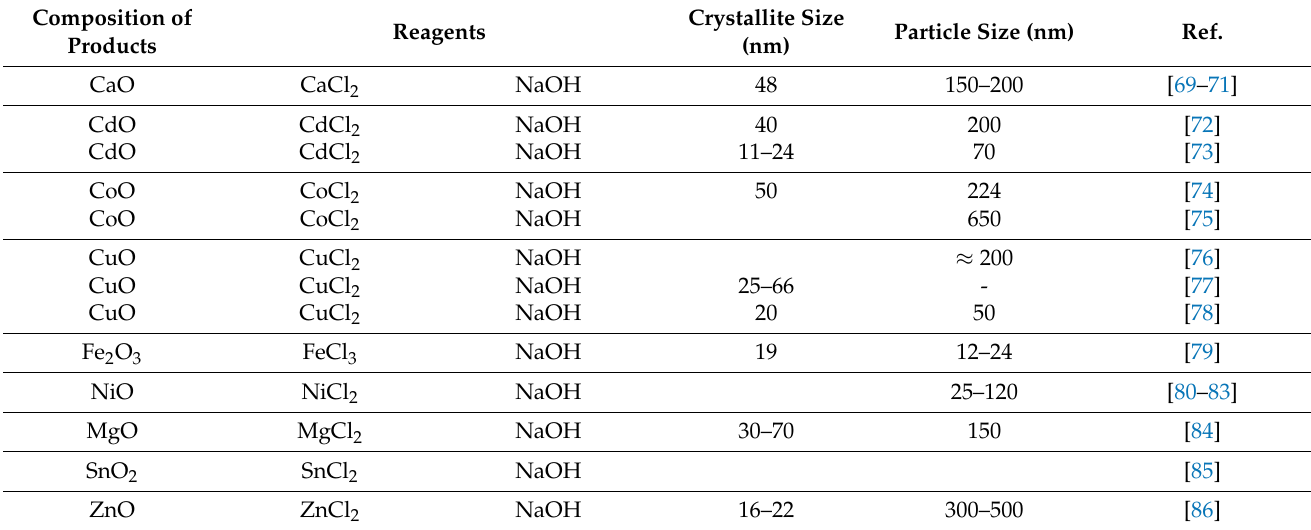
Table 1. Summary table for the synthesis of metal oxide nanoparticles using metal chloride solutions and NaOH solution as reagents. Crystallite Size Particle Size (nm) (nm)